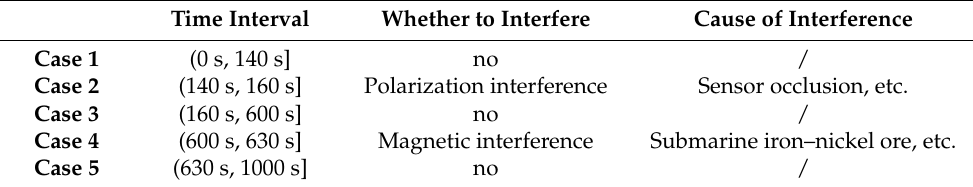
Table 4. The simulation settings of interference cases in the navigation process.